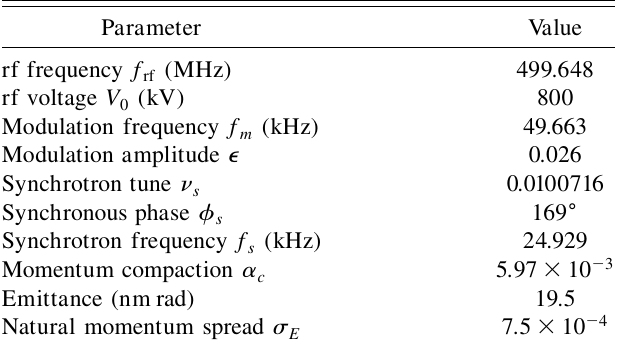
TABLE I. Operation parameters associated with the archived data in Fig.